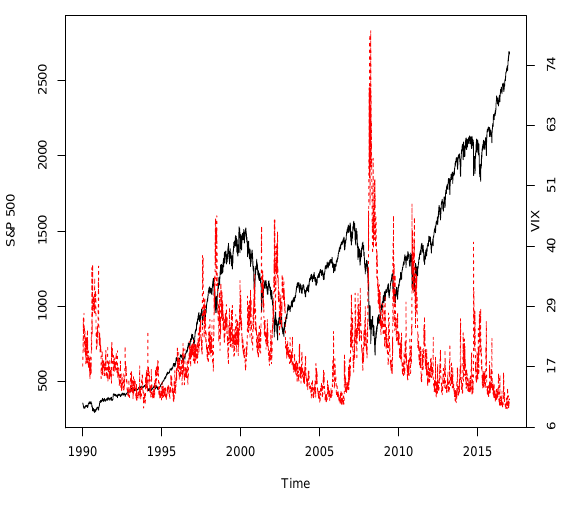
Figure 1. Raw Data Plot (01/02/1990–12/29/2017; black: S&P 500 Index; red: